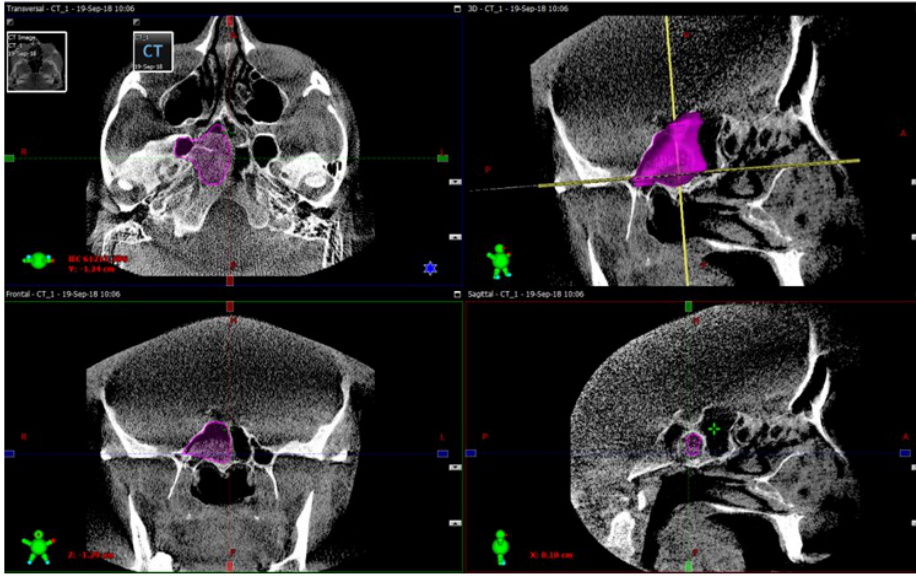
Figure 1. Sphenoid sinus volume measurement procedure based on computed tomography (CT) scanning followed by 3D reconstruction. The opacification of the sphenoid sinus is marked in purple. The exemplified opacified sinus volume highlighted by violet in the figure equals 9.4 cm 3 . The green color denotes the scan area; the red color marks isocenter position; the blue color is horizontal axis; while the yellow line denotes the head anatomical axis.